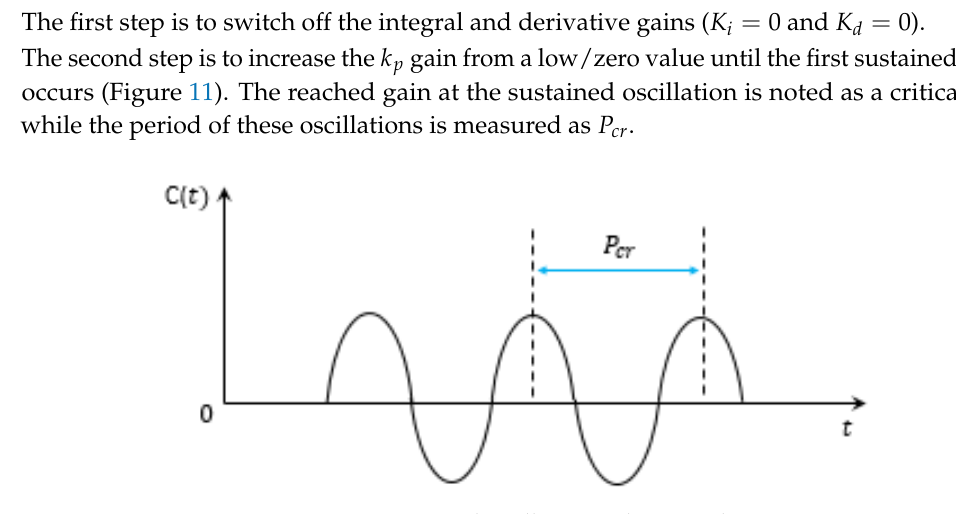
Figure 11. Sustained oscillation with a period P cr .